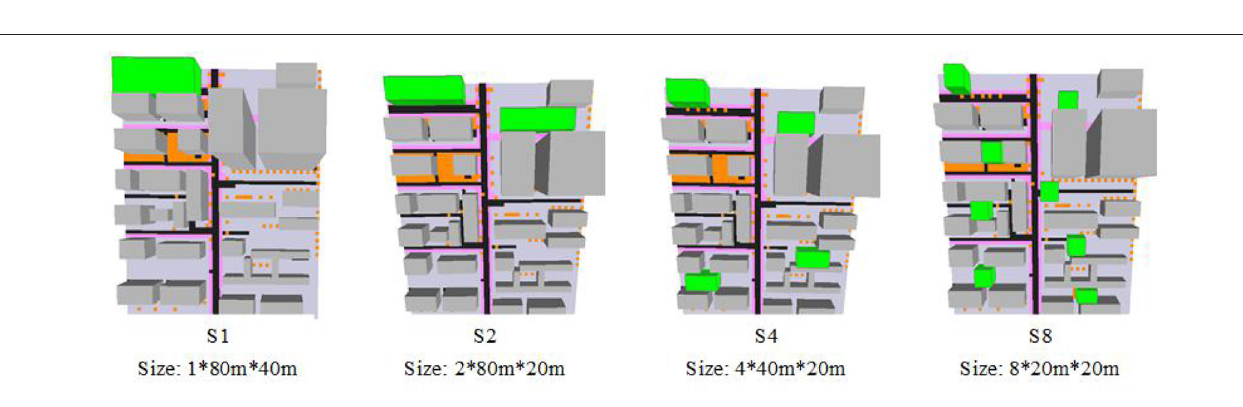
FIGURE 10 | Different tree layouts in Chigang